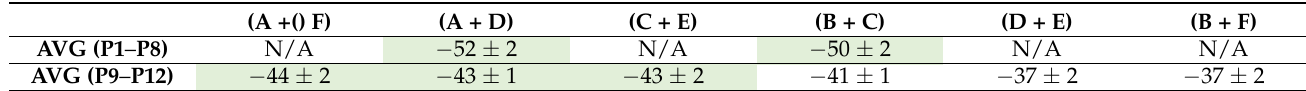
Table 1. Hydrogen-bond energies (in kJ/mol) for each combination synthon for molecules P1 – P12 . Green shade indicates the most likely predicted synthons by this method.